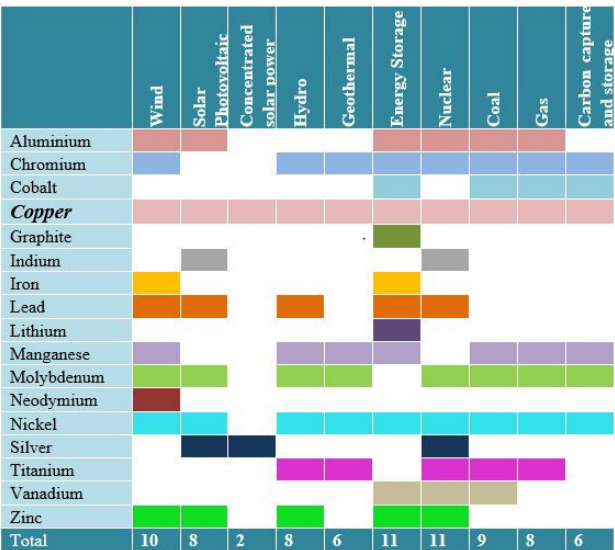
Figure 2. Mapping of minerals with their relevance in low-carbon technology [3].